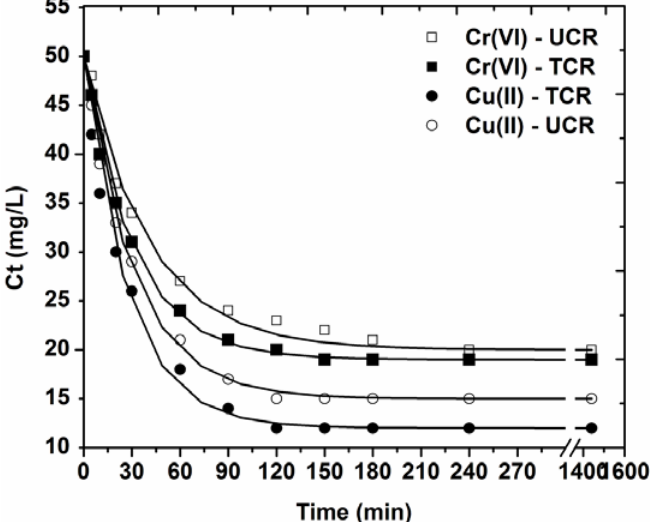
Figure 3. Effect of contact time on adsorption of Cu(II) and Cr(VI) onto treated and untreated coffee residues (pH = 5, 50 mg/L ion concentration, 1 g/L adsorbent, T = 25 °C, 140 rpm, 5 min–24 h